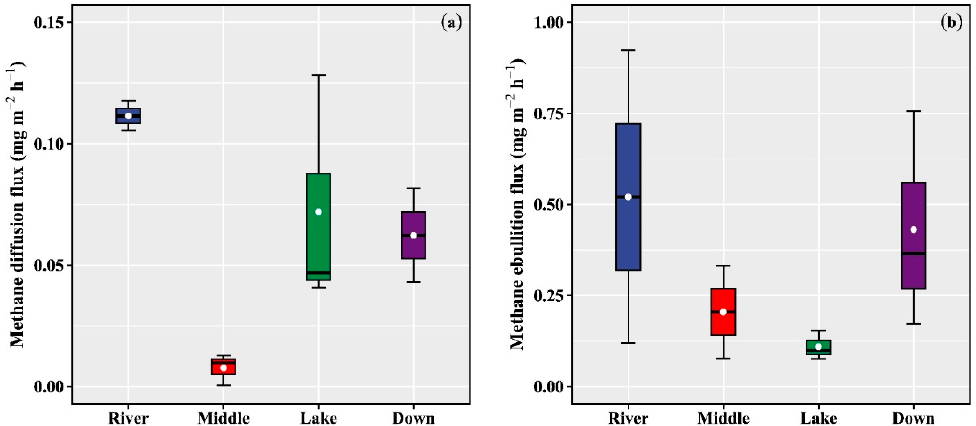
Figure 3. CH 4 diffusion flux ( a ) and ebullition flux ( b ) in different subregions (Symbols are similar to Figure